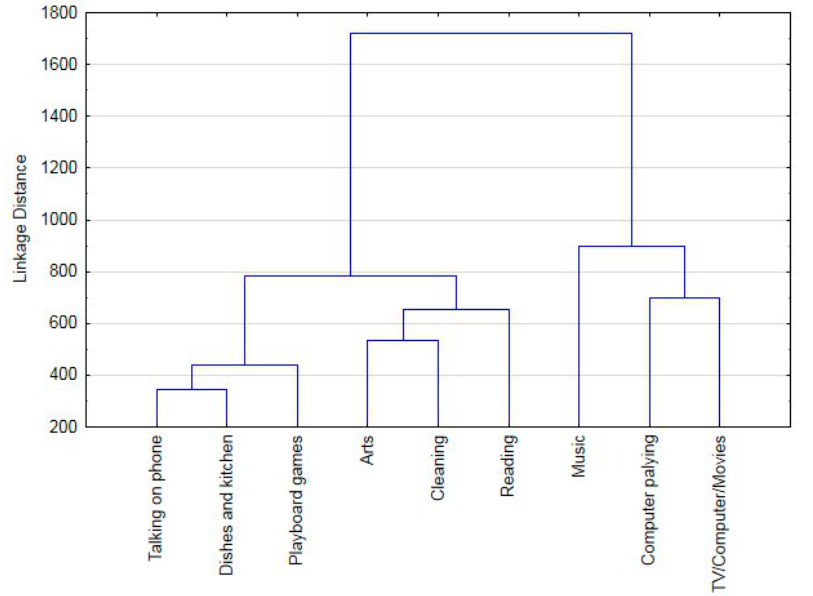
Figure A5. Tree diagram for cluster analysis performed for question referring to sedentary behaviors. Ward’s method was used. The Manhattan distances were used for measuring. The cut-off point is at the distance 850, clustering variables into four groups.